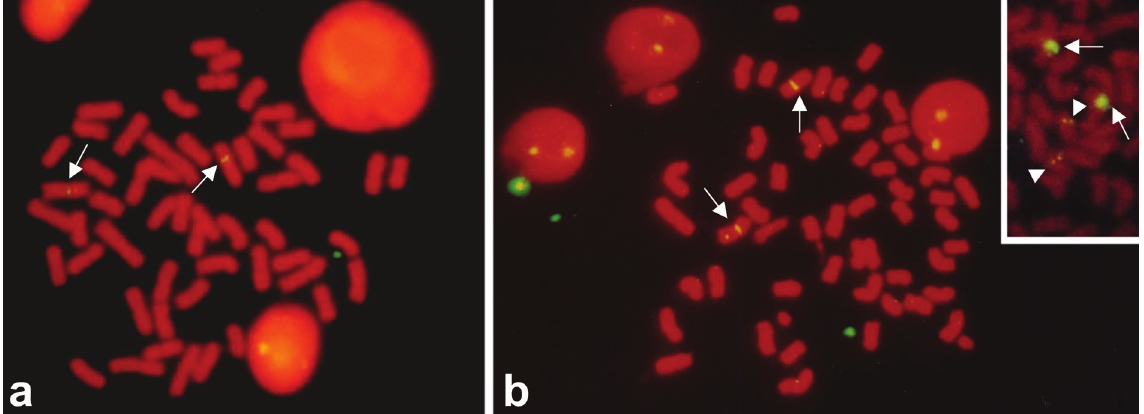
Figure3 -5SrDNAfluorescence insitu hybridizationofmetaphasechromosomespreadsof(a) Steindachnerinainsculpta and(b) Cyphocharaxmodesta. A single 5S rDNA locus is shown in a and b (arrows). In the detail, minor 5S rDNA loci (arrowheads) that were also observed in C. modesta .